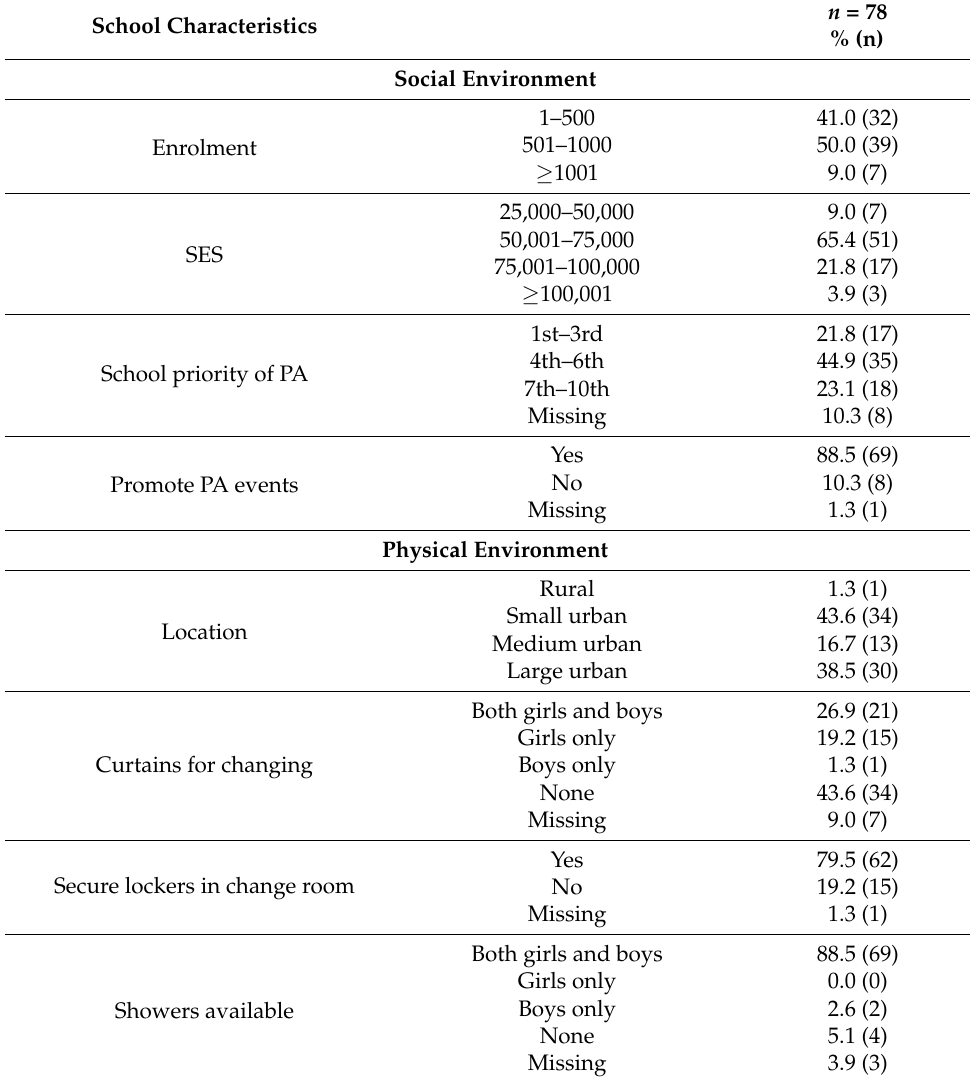
Table 1. Baseline characteristics of schools participating in Year 2 (2013–2014), Year 3 (2014–2015), and Year 4 (2015–2016) of the COMPASS Study in Ontario and Alberta,